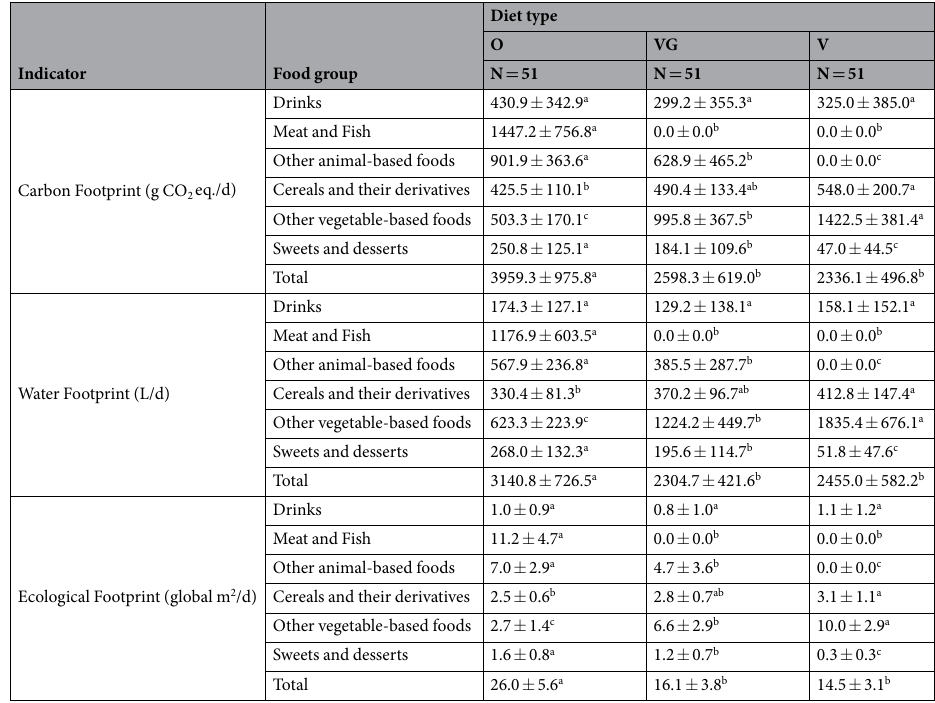
Table 4. Daily carbon footprint, water footprint, and ecological footprint values of food groups (as average of 7-d food record) for each of the three diet groups. Values are mean ± standard deviation of fifty-one independent measurements. Different letters indicate significantly different values ( P < 0.05) as calculated by one-way ANOVA with post hoc Tukey HSD test among the three diet groups. O, omnivores; VG, ovo-lacto- vegetarians; V, vegans. Drinks: alcoholic beverages, soft drinks, and fruit juices. Meat and Fish: meat and meat products, and fish. Other animal-based foods: eggs, milk and dairy products, and animal fat. Cereals and their derivatives: cereals and their derivatives. Other vegetable-based foods: fruit, vegetables, nuts and dried fruits, legumes, potatoes and other tubers, vegetable alternatives, and vegetable fat. Sweets and desserts: sweets and